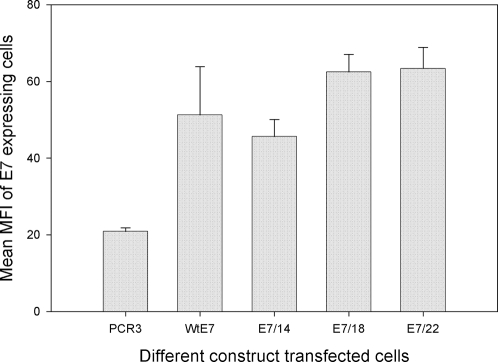
FSCAN analysis of cells transfected with E7 expression constructs.Expression of E7 protein was detected in immortalized rabbit cells transfected with expression constructs of the E7 genes and subjected to FSCAN analysis. All analyses were done in duplicate. E7/18 and E7/22 showed the highest expression levels.( p<0.05, unpaired student t test), when compared to the control.